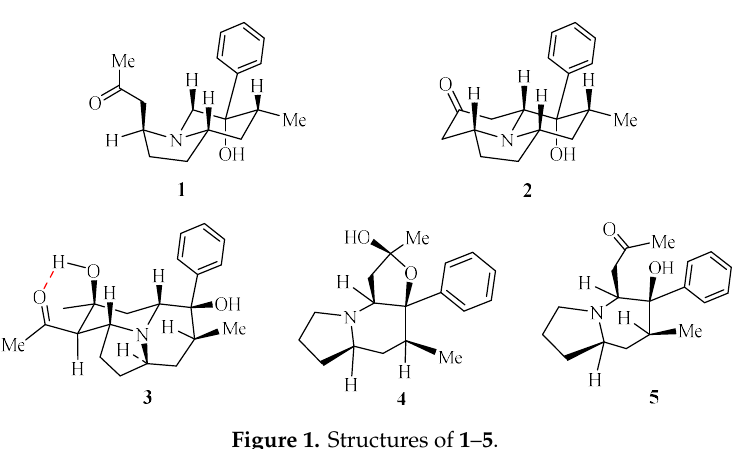
Figure 1. Structures of 1 – 5 .